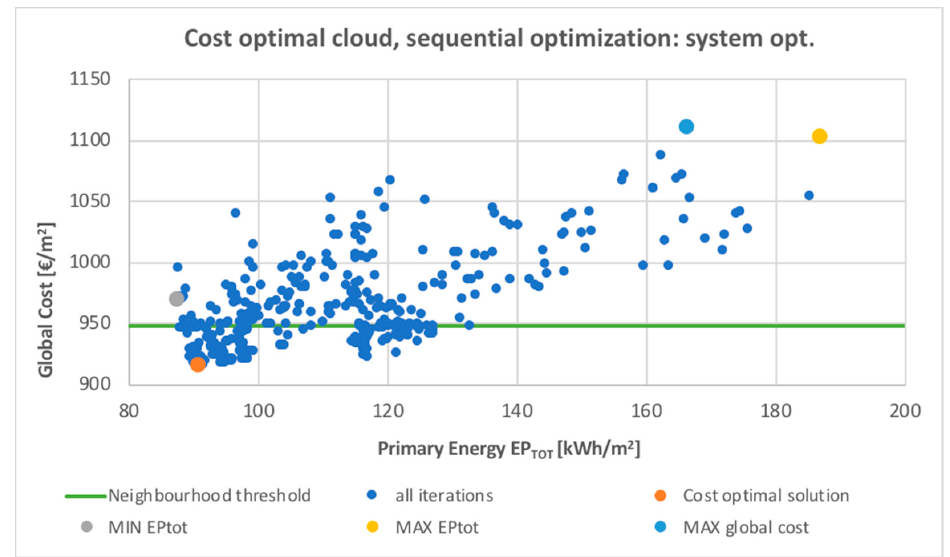
Figure 9. Cost-optimal cloud: financial objective, sequential optimization, energy supply.